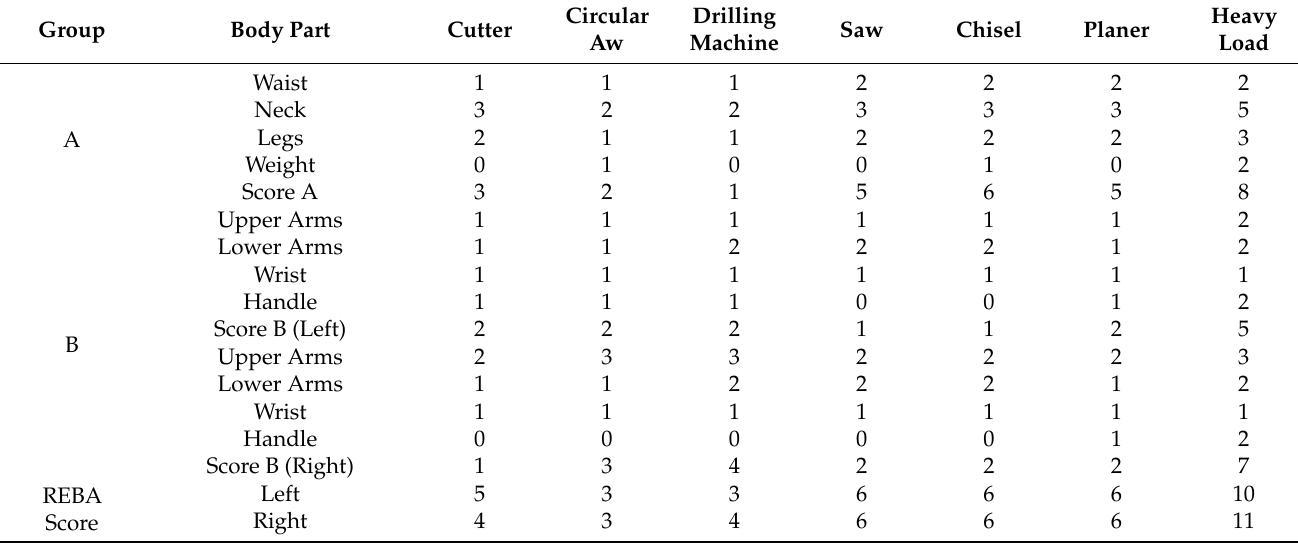
Table 19. REBA evaluation results by CREBA